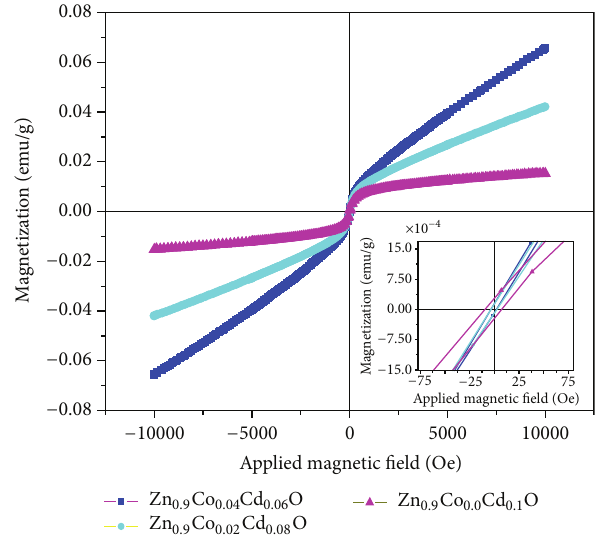
Figure 7: M - H loop of Zn 0.9 Co 0.1−𝑥 Cd 𝑥 O ( 𝑥 = 0.06, 0.08, and 0.1). The inset shows corresponding magnified